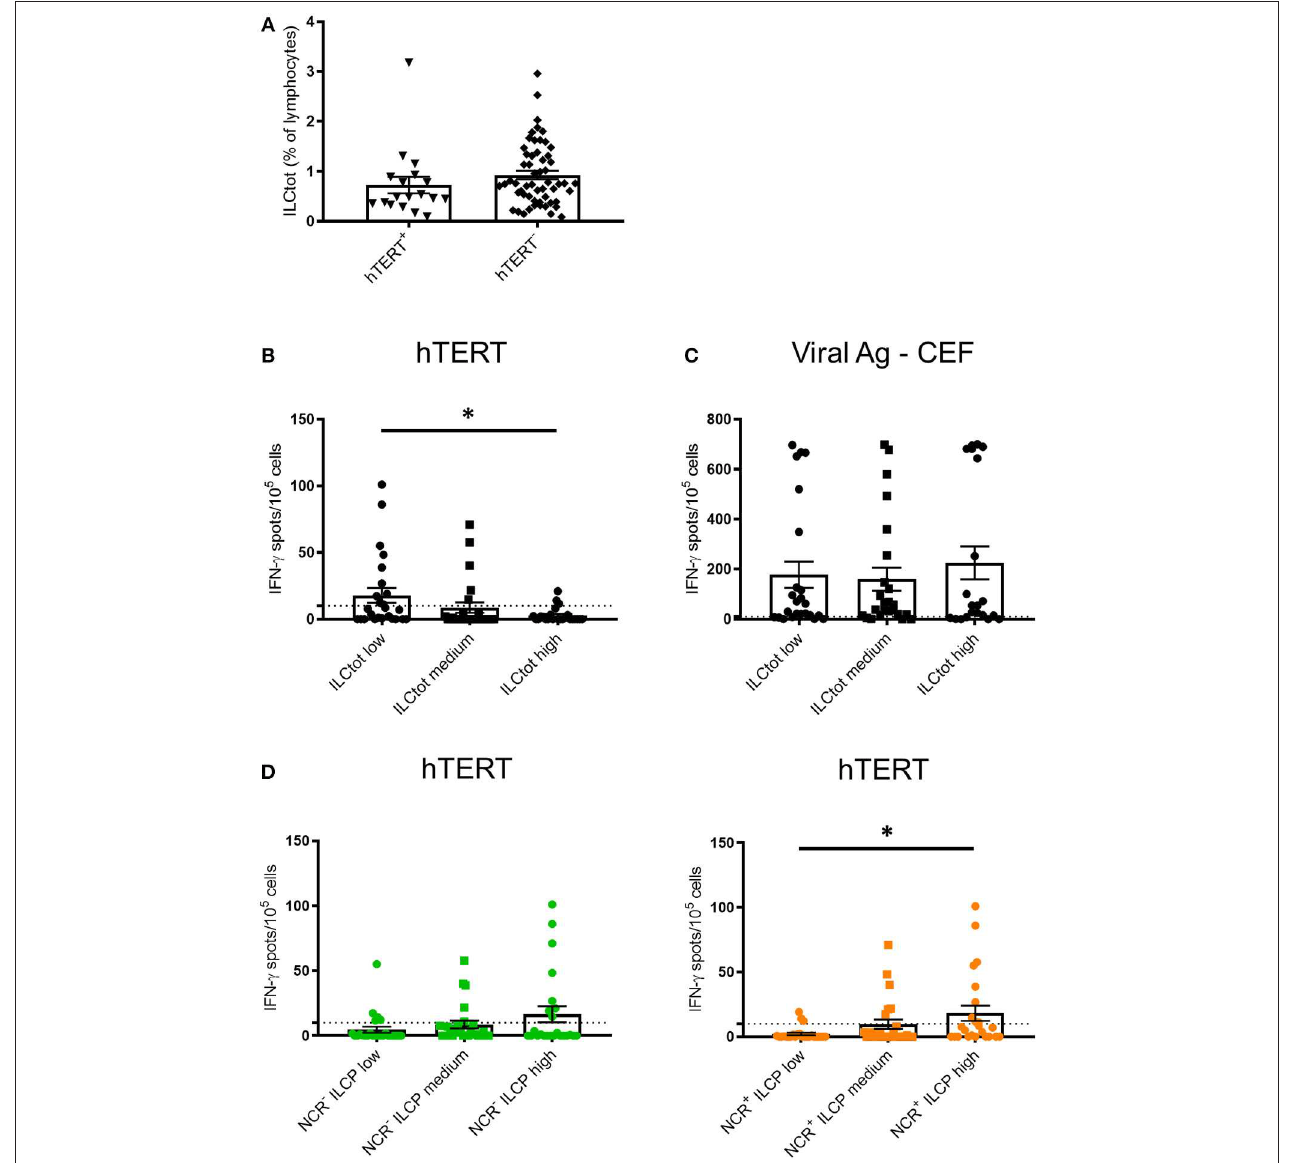
FIGURE 3 | IFN- γ ELISpot hTERT responses relative to the distribution of ILCs. PBMCs from 74 chemotherapy-naïve metastatic colorectal cancer patients were cultured with a mixture of 8 hTERT peptides (TERT 44 − 58 , TERT 578 − 592 , TERT 921 − 935 , TERT 1055 − 1069 , TERT 541 − 555 , TERT 573 − 587 , TERT 613 − 627 , and TERT 911 − 925 ) at 5 µ g/mL. The T cell reactivity against the hTERT peptides was detected by IFN- γ ELISpot assays, as described in the Material and Methods. Stimulation with Viral Ag-CEF peptides was used as control for T cell reactivity. (A) The frequency of ILCtot in the PBMCs of each patient was analyzed based on the positive ( n = 18) or negative ( n = 56) response to hTERT. (B,C) Results are shown as the means of IFN- γ spot numbers (magnitude) and the ILC frequencies (ILCtot distributed into low ( n = 25), medium ( n = 25) and high ( n = 24) terciles) for hTERT responses (B) and Viral Ag-CEF responses (C) . (D) Results are shown as the means of IFN- γ spot numbers (magnitude) and frequencies of NCR − ILCP (left) and NCR + ILCP (right) distributed among the low ( n = 25), medium ( n = 25) and high ( n = 24) terciles. Columns, the means of spots from triplicate wells; bars, SEM. * p < 0.05, as determined by Student’s t